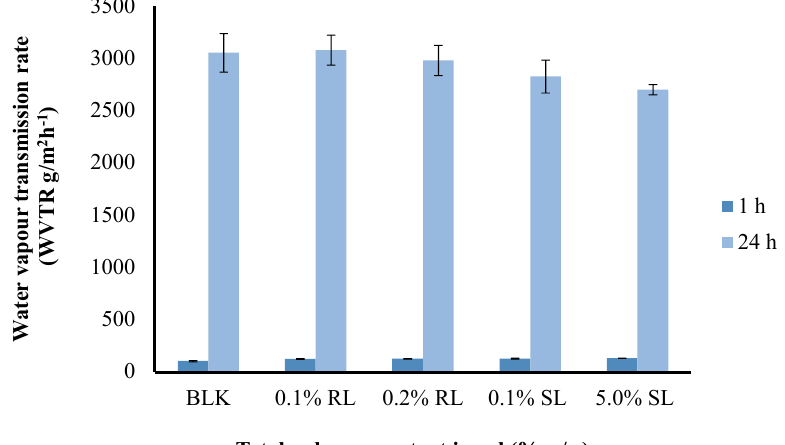
Figure 9. Comparison of the water vapor transmission rate (WVTR) of optimized BLK and BSs loaded wafers.